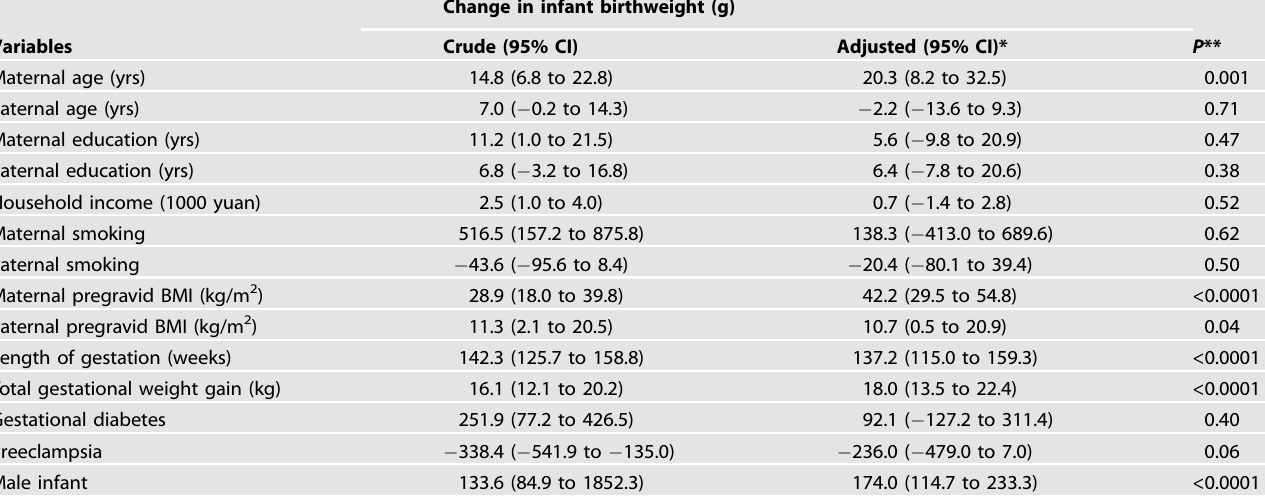
Table 2. Change in infant birthweight in relation to pregravid and pregnancy factors. Data were presented as the change in birthweight per unit change in the indicated variable, either unadjusted (crude) or after adjustment for all of the other listed variables.